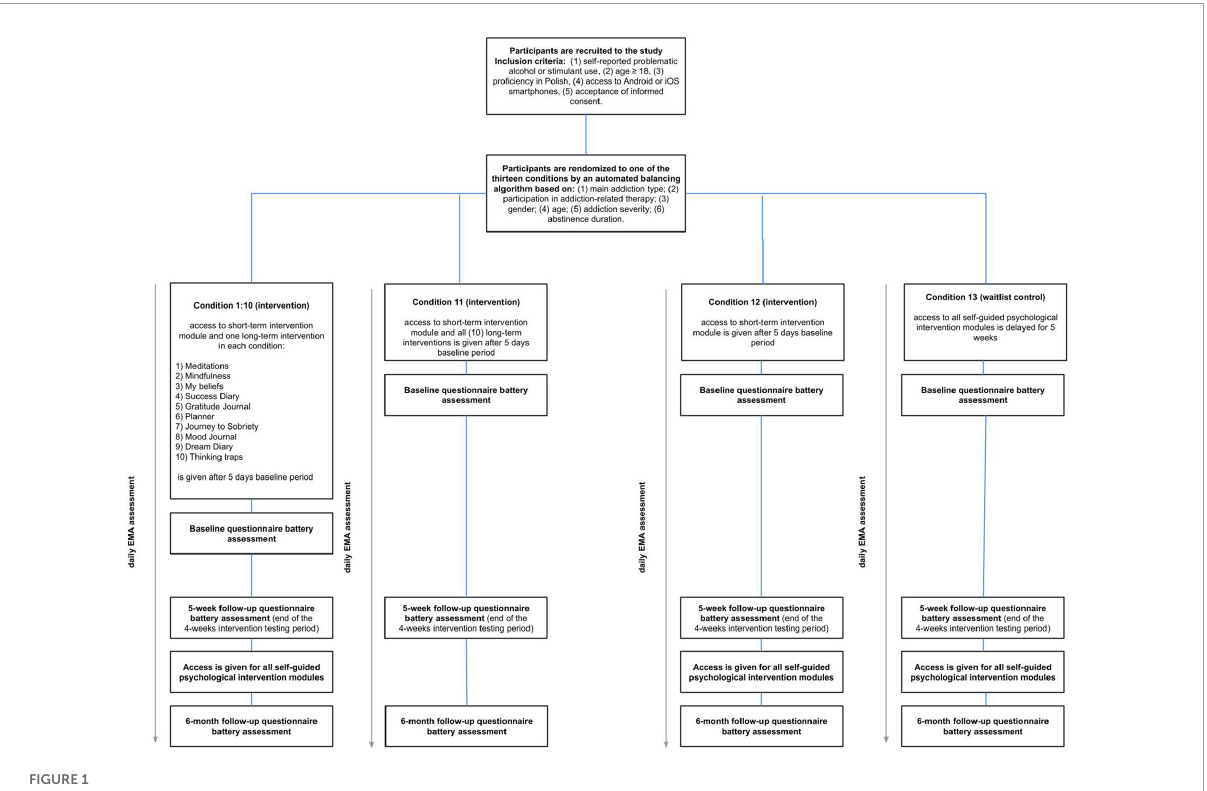
FIGURE1 Participant flow